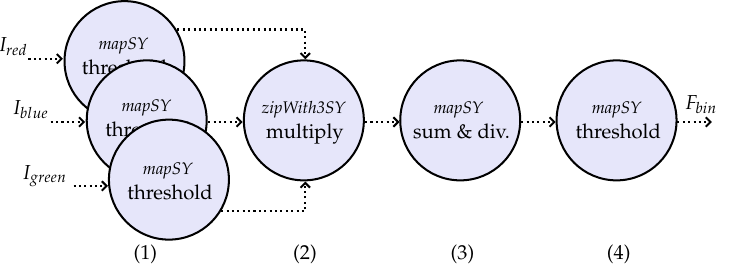
Figure 2. ForSyDe model for the cloud detection algorithm using the synchronous model of compu- tation (modified from [12]). In ( 1 ), one threshold operation (with the value τ 1 ) is applied to each one of the input bands. In ( 2 ), the resulting binary matrices from each band are element-wise multiplied. Then, the elements are summed and divided in ( 3 ) according to the dimensions of the tiles. In ( 4 ), another threshold operation (with the value τ 2 ) is performed to label each tile as “No-cloud” or